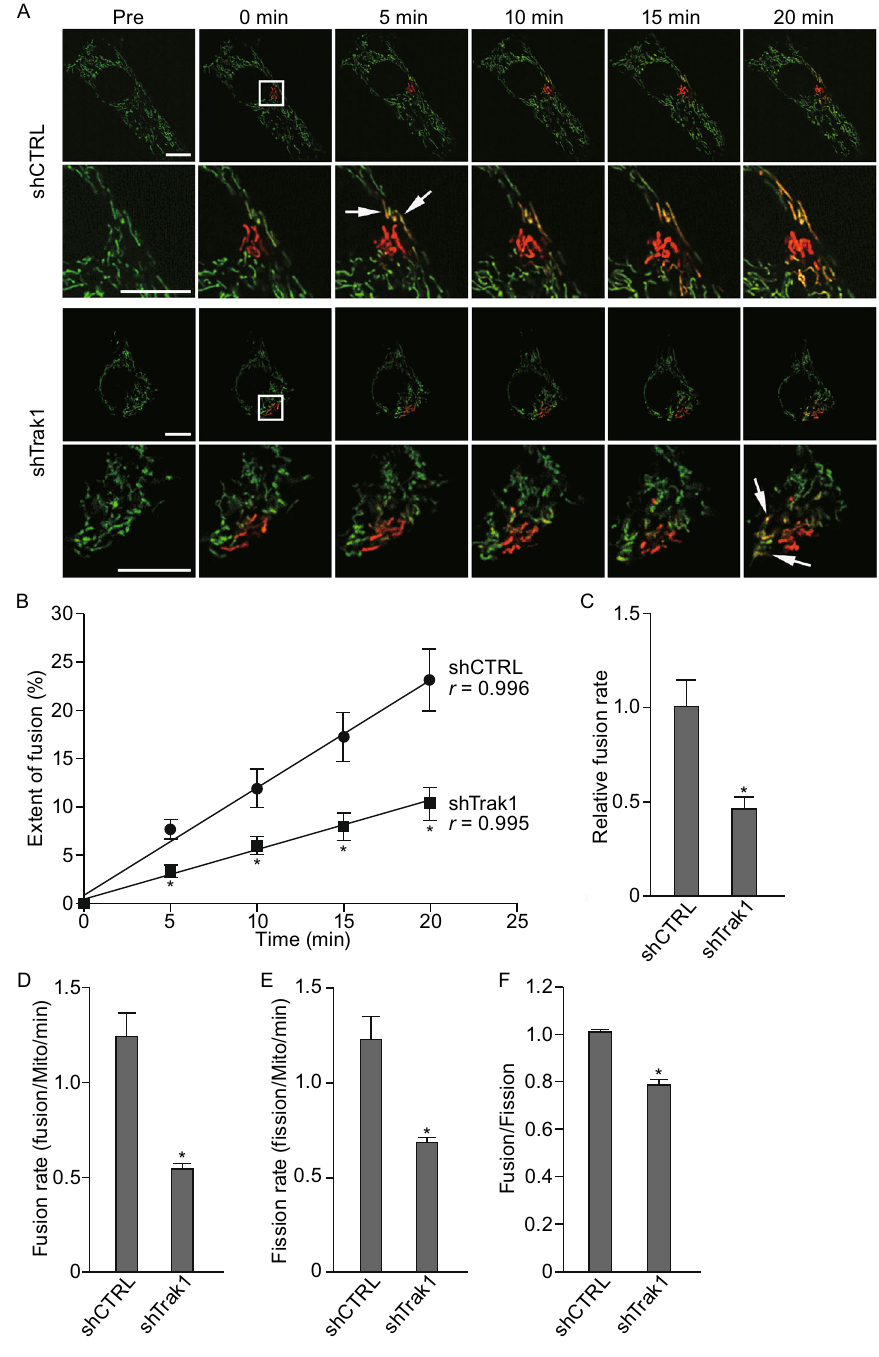
photo-switchable fl uorescent protein which can be irre- versibly converted from green to red fl uorescent state by photoactivation (Magrane et al., 2012). The fusion between red (photoactivated) and green (non-activated) mitochondria